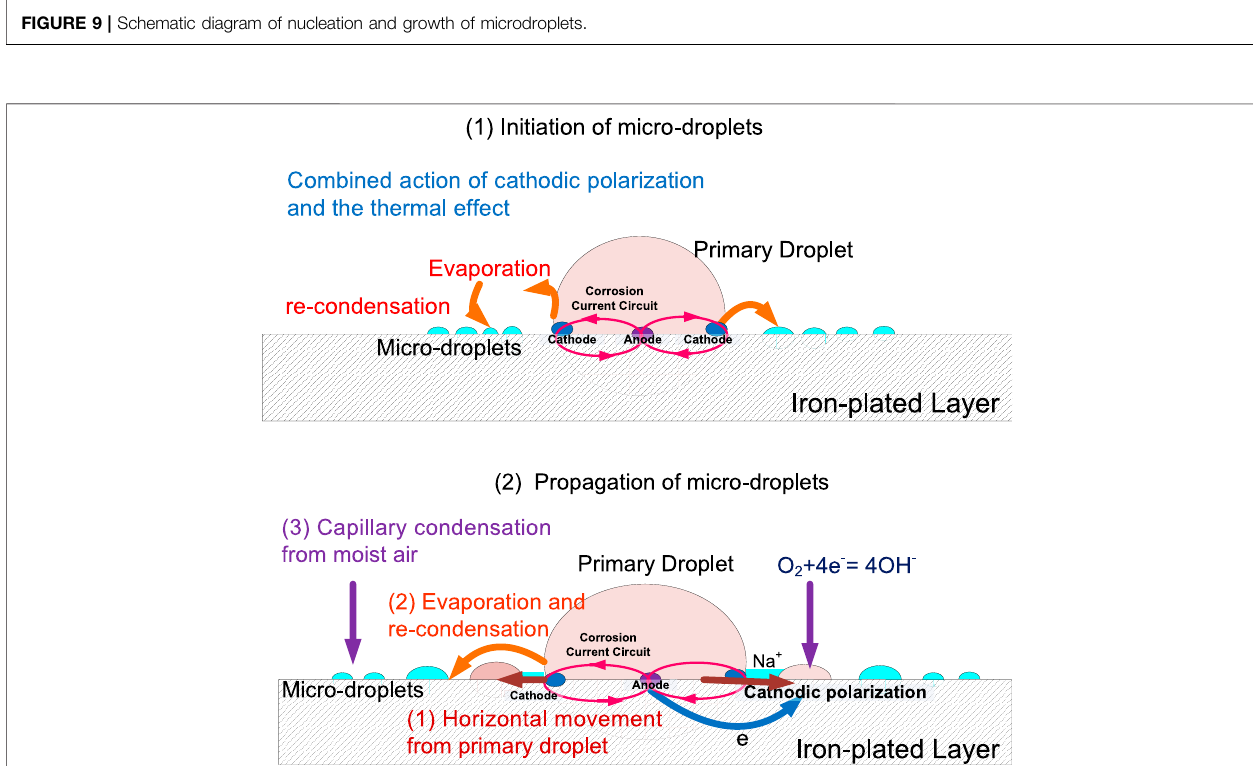
FIGURE 10 | Schematic representation of microdroplets formation